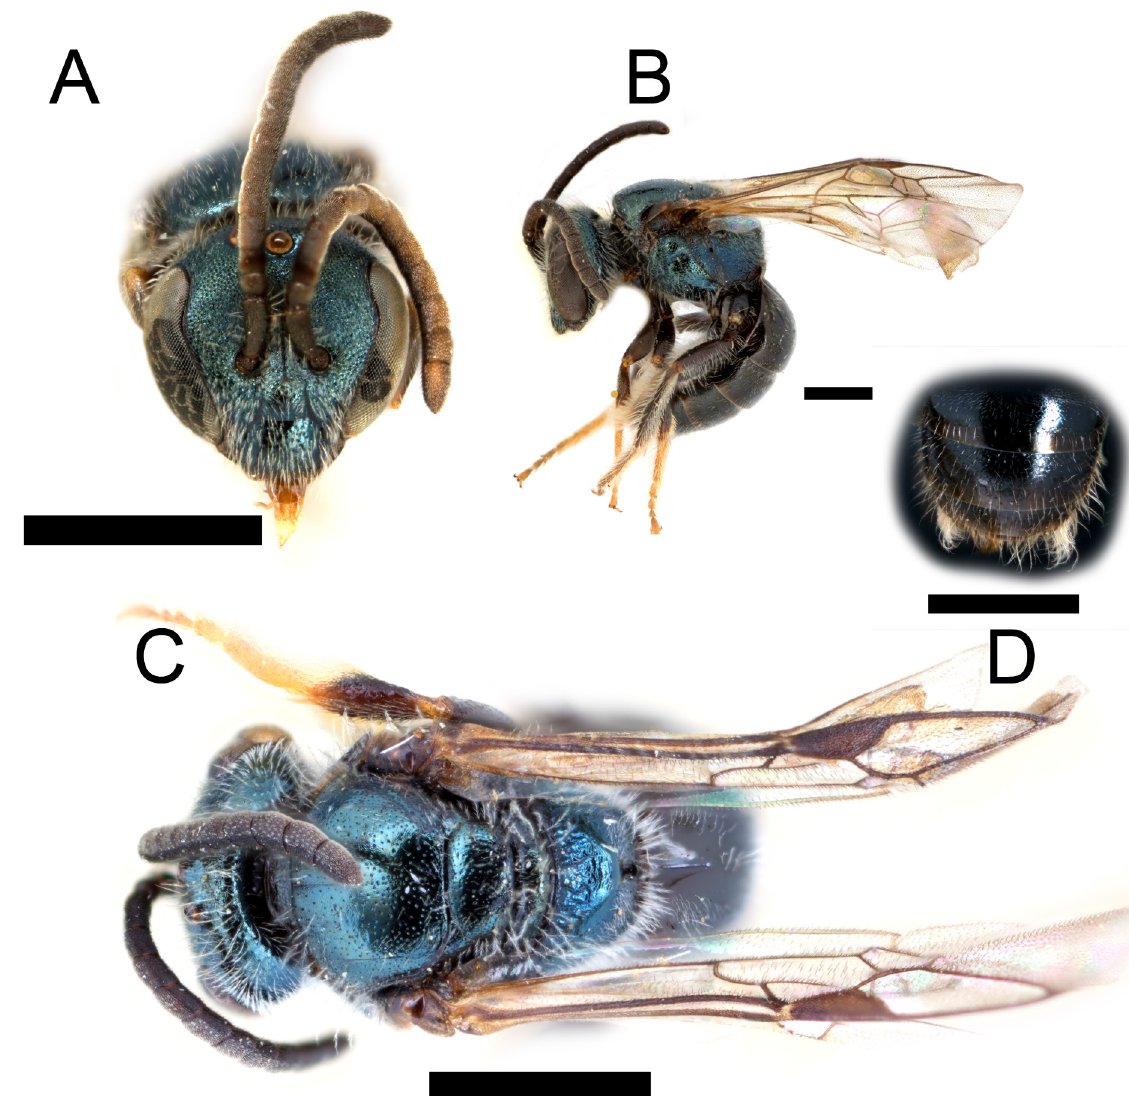
Fig. 22. Lasioglossum gundlachii (Baker, 1906), ♂. A . Face. B . Lateral habitus. C . Dorsal habitus. D . Dorsal view of metasomal apex. Scale bars = 1